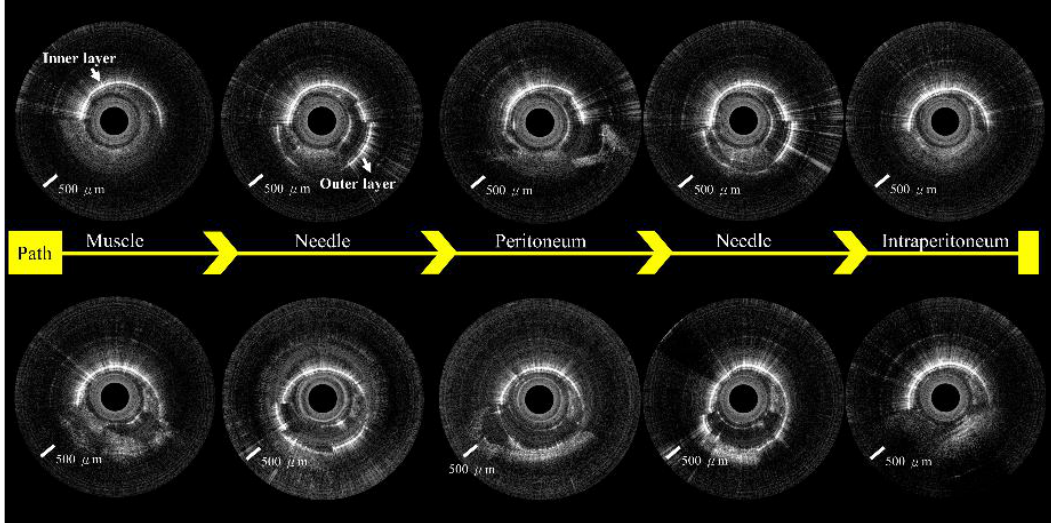
Figure 9. OCT images show the puncture path from the paramedian region of the belly.